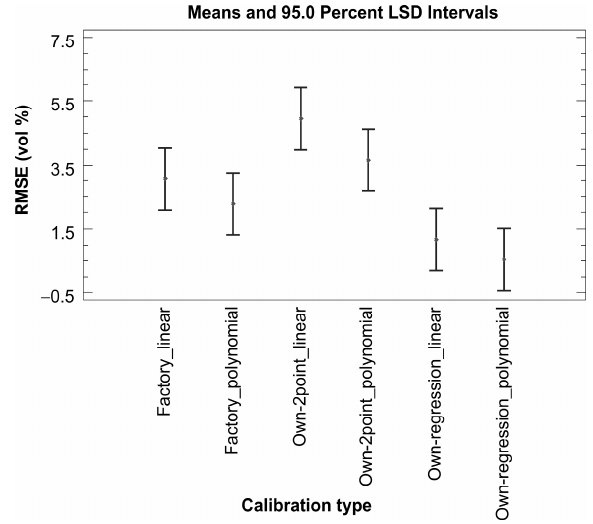
Figure 8. ThetaProbe—means and 95.0% LSD intervals of analysis of variance for RMSE and calibration type.